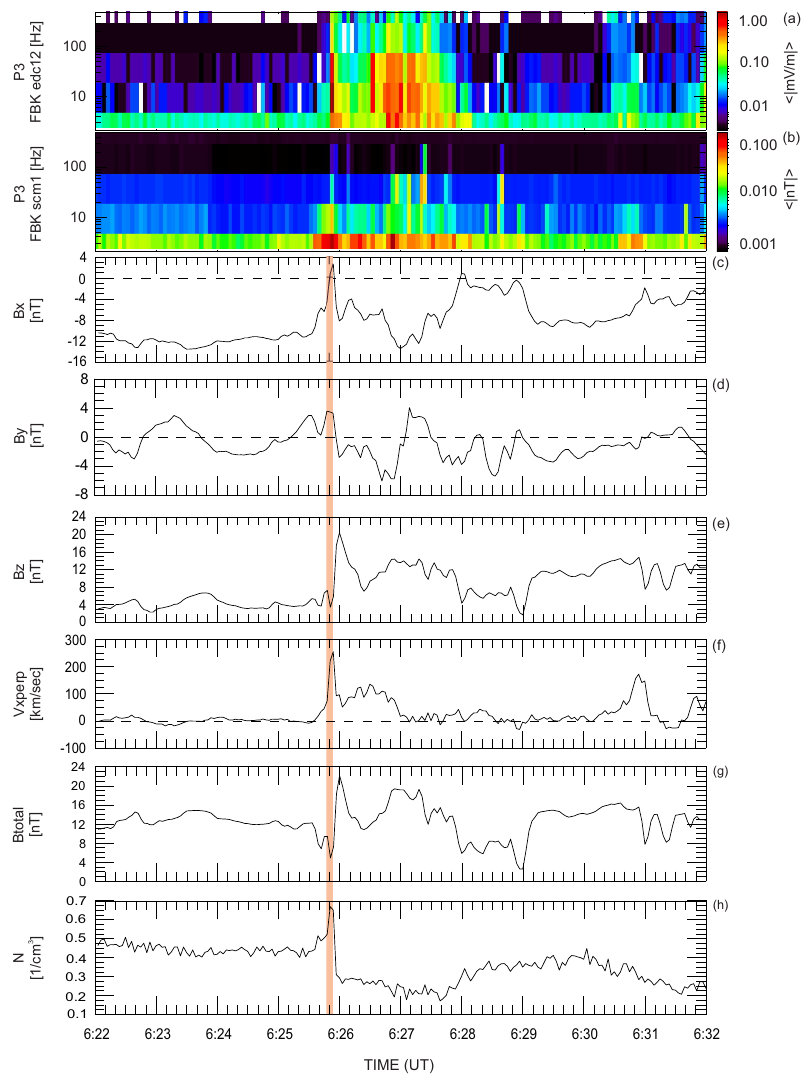
Fig. 4. Same format as Fig. 2 but for a 22 February 2008 substorm event. The measurements are from P3 spacecraft for the time interval 06:22–06:32UT and the spectral bands cover the frequency range from ∼ 2Hz to ∼